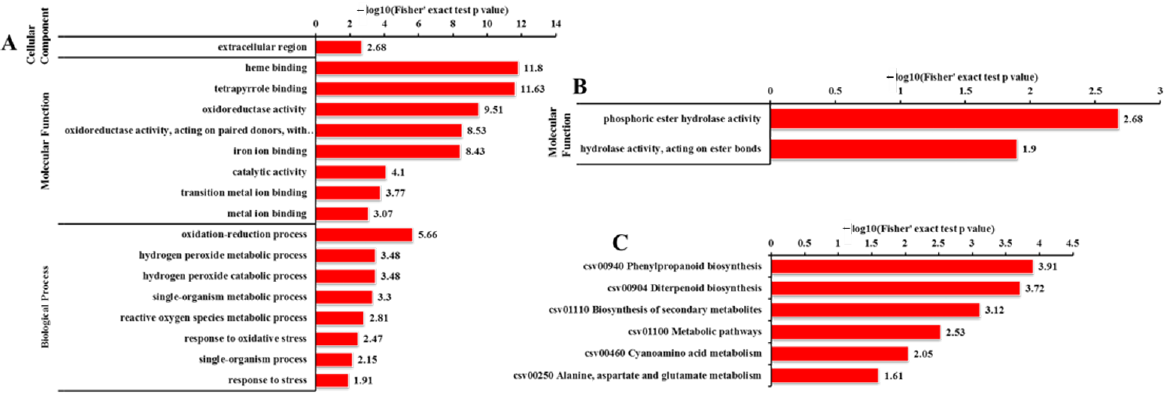
Figure 20. GO and KEGG a nalyses of the 42 cor-DEG-DEP genes. ( A ) GO enrichment analysis of PU-TU genes. ( B ) KEGG pathway analysis of PU-TU genes. ( C ) KEGG pathway analysis of PD-TD genes. T: transcript; P: protein species; N: no change; U: up-accumulation; D: down-accumulation.